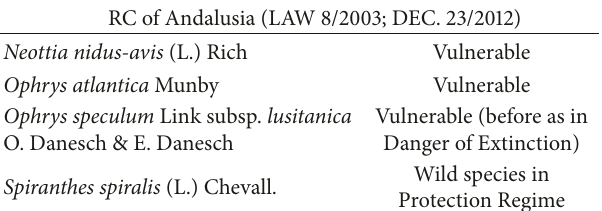
Table 2: Species included in the regional catalogue (RC) of Andalu- sia (DEC 23/2012).